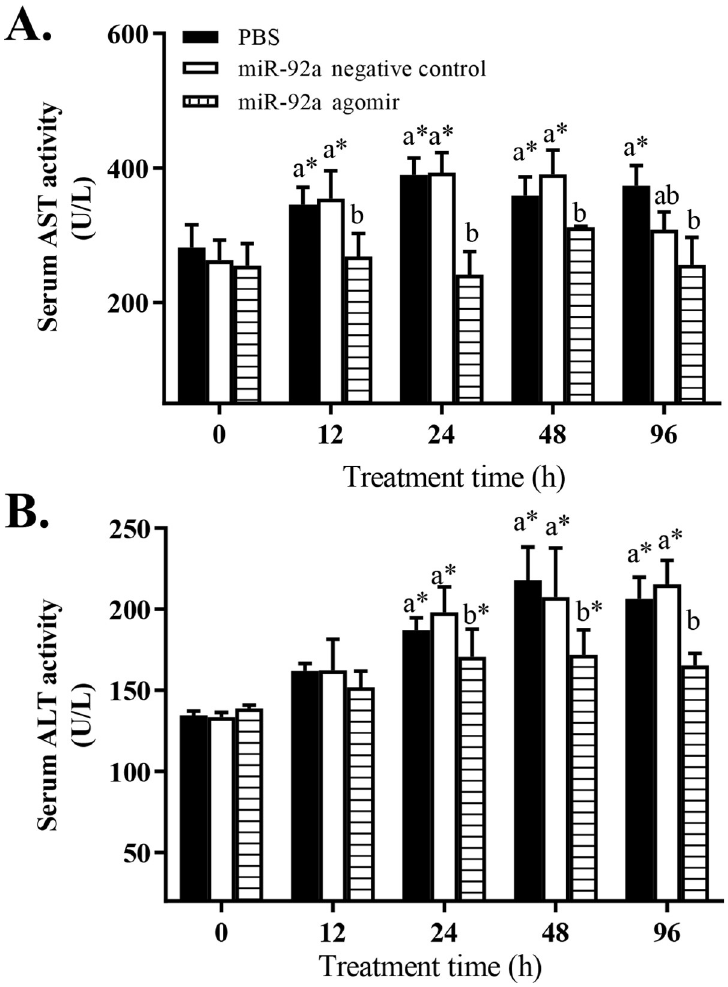
Fig 6. Effect of promoting miR-92a expression on serum aspartate aminotransferase (A) and alanine aminotransferase (B) activities in GIFT under hypoxia stress. At 12 h after miR-92a agomir injection or PBS (control), juveniles were subjected to hypoxia stress for 96 h. � Indicates significant differences between of pre- and post- injection in the same experimental group (independent samples t test; P < 0.05). Different lowercase letters indicate significant differences among different treatments at each sampling point (Duncan’s multiple comparison; P <